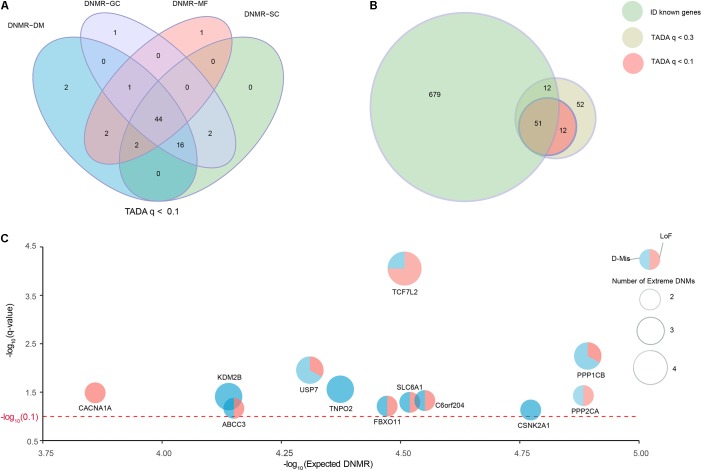
Identification of known and strong candidate ID risk genes. (A) Venn diagram denoting the overlap of the number of genes with q-values < 0.1 using TADA based on four background DNMRs. (B) The intersection of known ID genes, genes with q-values < 0.3 and genes with q-values < 0.1. Twelve genes with q-values < 0.1 were identified as strong candidate ID risk genes. (C) Scatter plots depicting the average DNMR for the 12 candidate ID risk genes. The x-axis shows the –log10 (Expected DNMR) value representing the mutation rate in the TADA program and the y-axis represents the –log10 (q-value) indicating the predicted degree of association (red dotted line, q-value = 0.1). The size of each point was weighted with the extreme DNMs number.